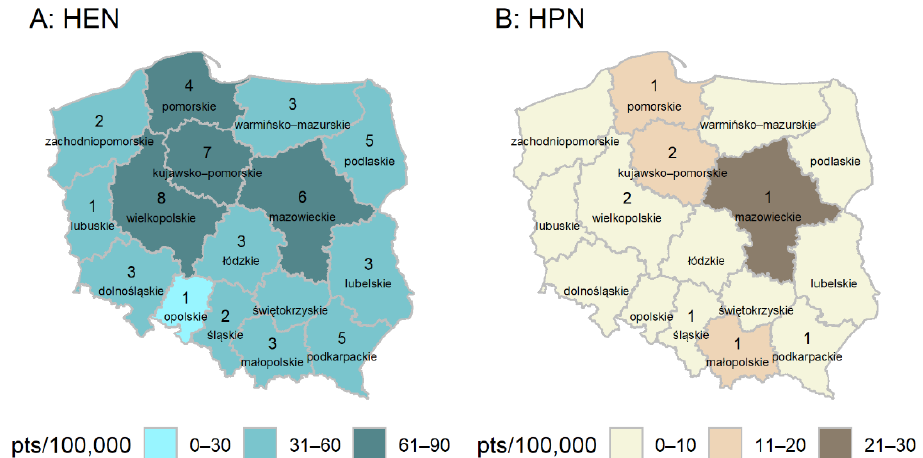
Figure 2. The number of patients treated with ( A ) HEN and ( B ) HPN between 2010 and 2018 per 100,000 underage population, and number of centers by voivodeship.